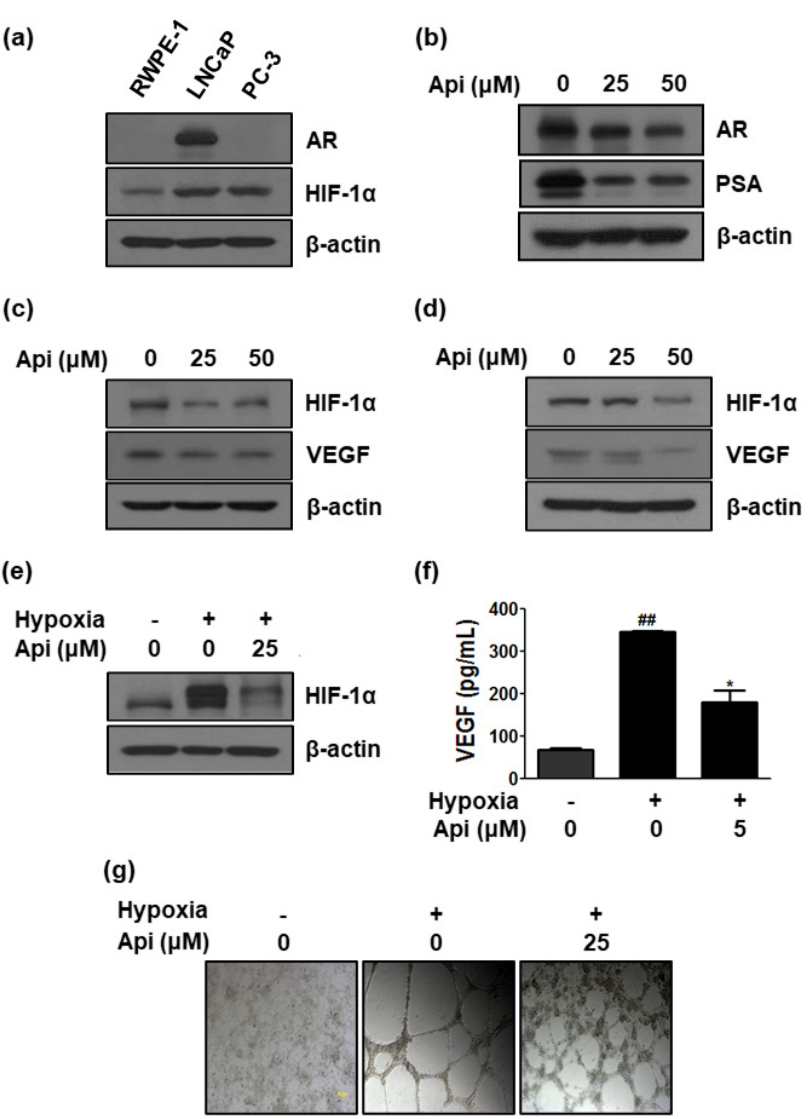
Figure 4. Effect of apigetrin on AR, HIF-1 α , and VEGF expression in LNCaP and PC-3 cells and hypoxia-induced angiogenesis in HUVECs. ( a ) Protein expression (basal level) of AR and HIF-1 α in prostate cell lines (human normal and cancer cells). LNCaP cells were treated with apigetrin (25 and 50 µ M) for 24 h. Cell lysates were prepared and subjected to western blotting to determine the expression of AR and PSA ( b ), HIF-1 α , VEGF, and β -actin ( c ). ( d ) PC-3 cells were treated with apigetrin (25 and 50 µ M) for 24 h. Cell lysates were prepared and subjected to western blotting to determine the expression of HIF-1 α , VEGF, and β -actin. ( e ) LNCaP cells were treated with apigetrin for 24 h under hypoxic conditions. Cell lysates were subjected to western blotting for HIF-1 α and β -actin. ( f ) The amount of VEGF in the conditioned medium from LNCaP cells treated with apigetrin and cultured under normoxic or hypoxic conditions for 24 h was measured using an ELISA kit. The bar graph represents the quantification of VEGF level. ## p < 0.01 (compared to normal control) and * p < 0.05 (compared to hypoxia control). ( g ) Tube formation in HUVECs treated with conditioned medium form hypoxia induced LNCaP